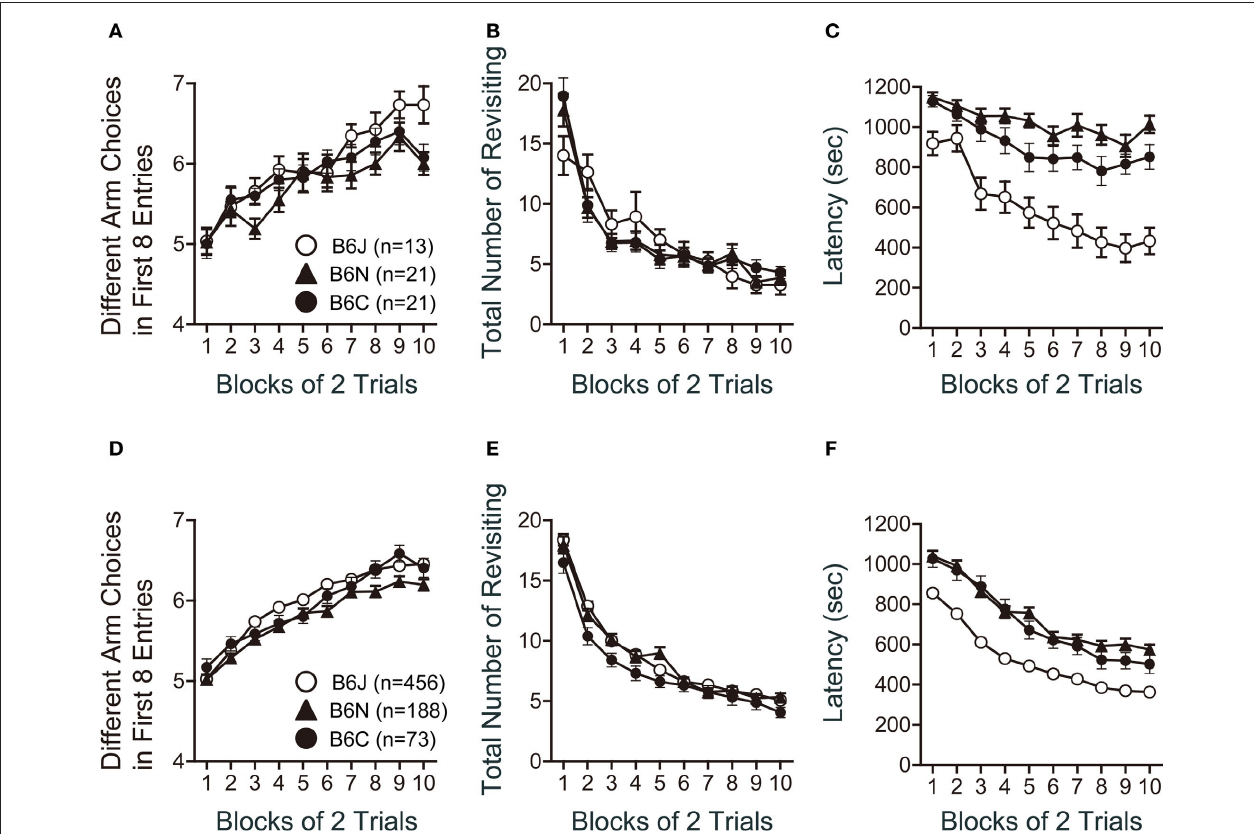
Figure 9 | Spatial working memory version of eight-arm radial maze test of C57BL/6 substrains. (A–C) Regular scale analysis. (D–F) Large-scale analysis. (A,D) Number of different arms chosen within the first eight choices. (B,e) Number of revisiting errors. (C,F) Latency. C57BL/6J showed the shortest latency to take all pellets. Error bars indicate